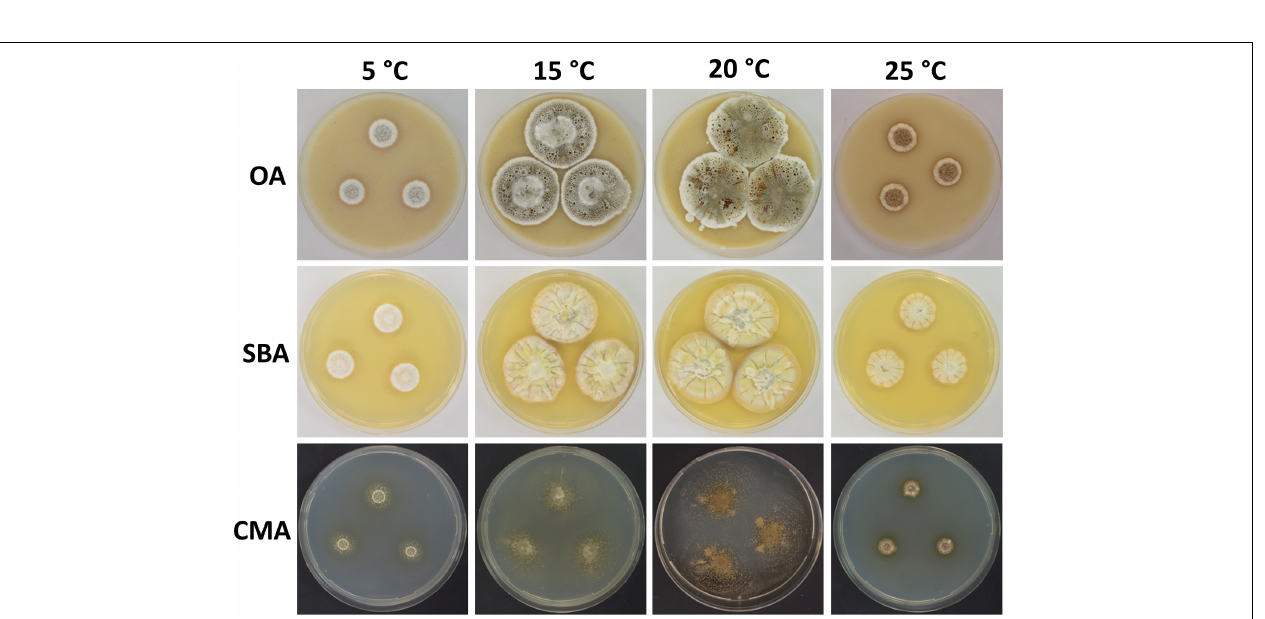
Frontiers in Microbiology |